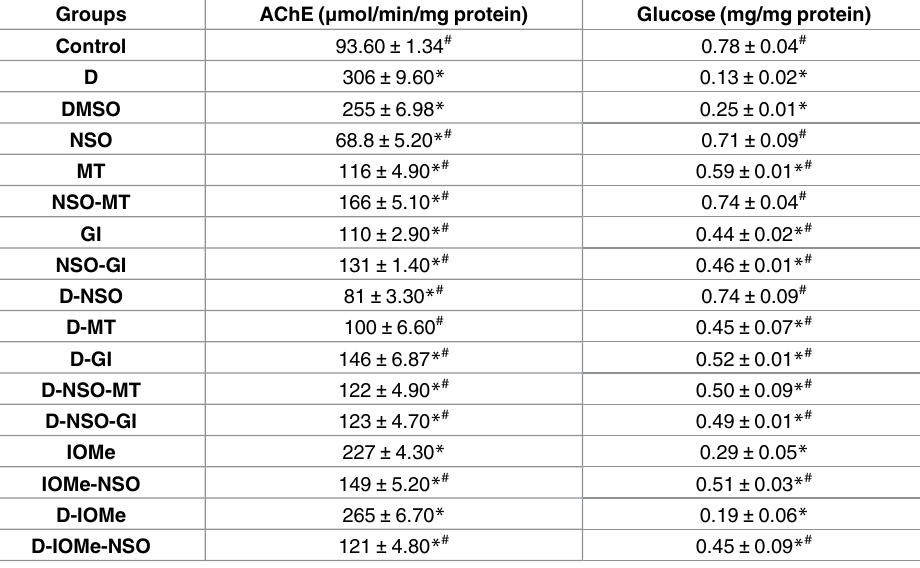
Table 6. AChE activities and glucose levels in the brain of diabetic rats and after treatment with NSO, antidiabetic drugs, combination therapy and